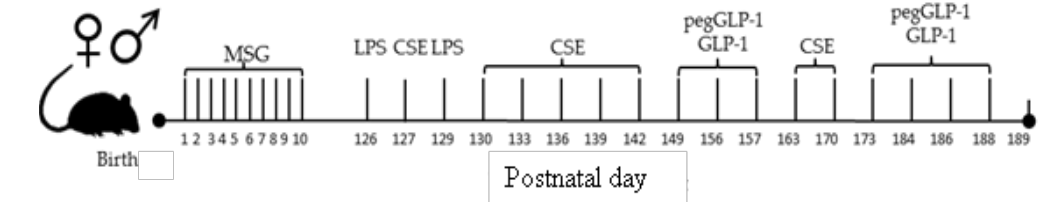
Figure 10. Schematic diagram of the experimental procedures.